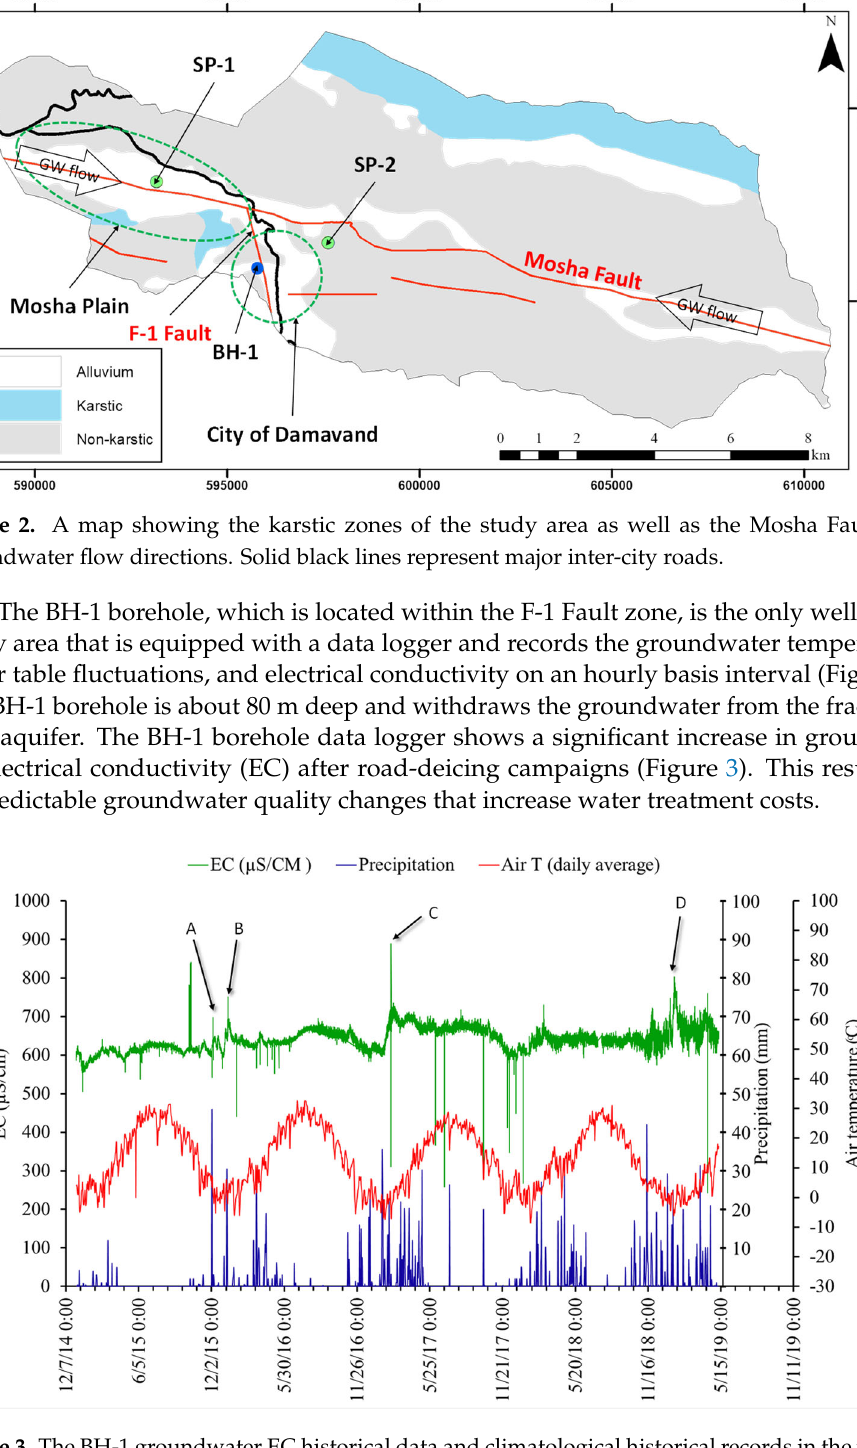
Figure 3. The BH-1 groundwater EC historical data and climatological historical records in the nearest meteorological station (Iran Meteorological Organization database, 2019). Points A, B, C, and D represent the groundwater EC increase after road-deicing campaigns. Some very low points in EC are due to the removal of the probe from the well to perform well maintenance operations. In these cases, air fills the space between the electrodes of the electrical conductivity sensor, which is an electrical insulator. The rest of the cases are probably due to the operation of the pump in the well, which causes air bubbles in the water and causes errors in the measurement of EC.